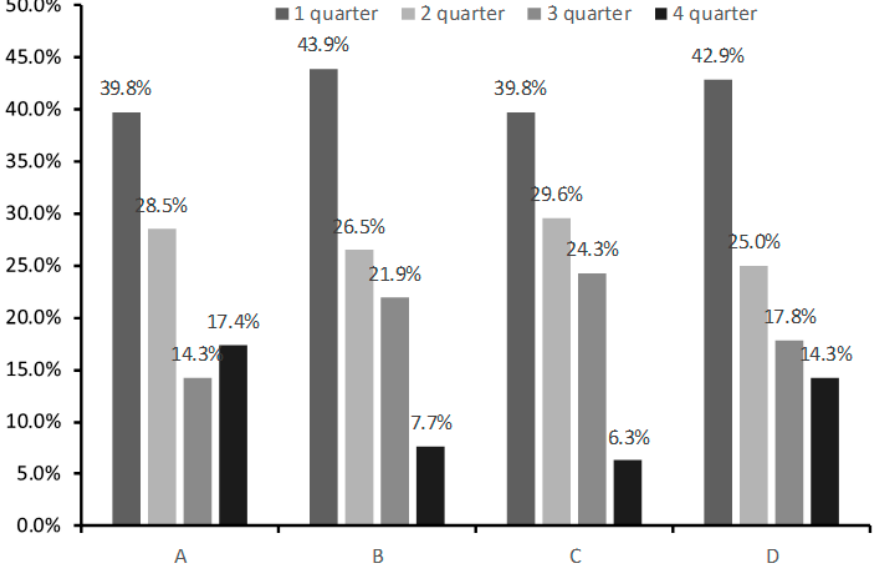
Figure 5. The prevalence of RAE in the leading Russian adult football teams ( A ), top tier football academies ( B ), junior national teams ( C ), and junior teams of the leading Russian football clubs ( D ).